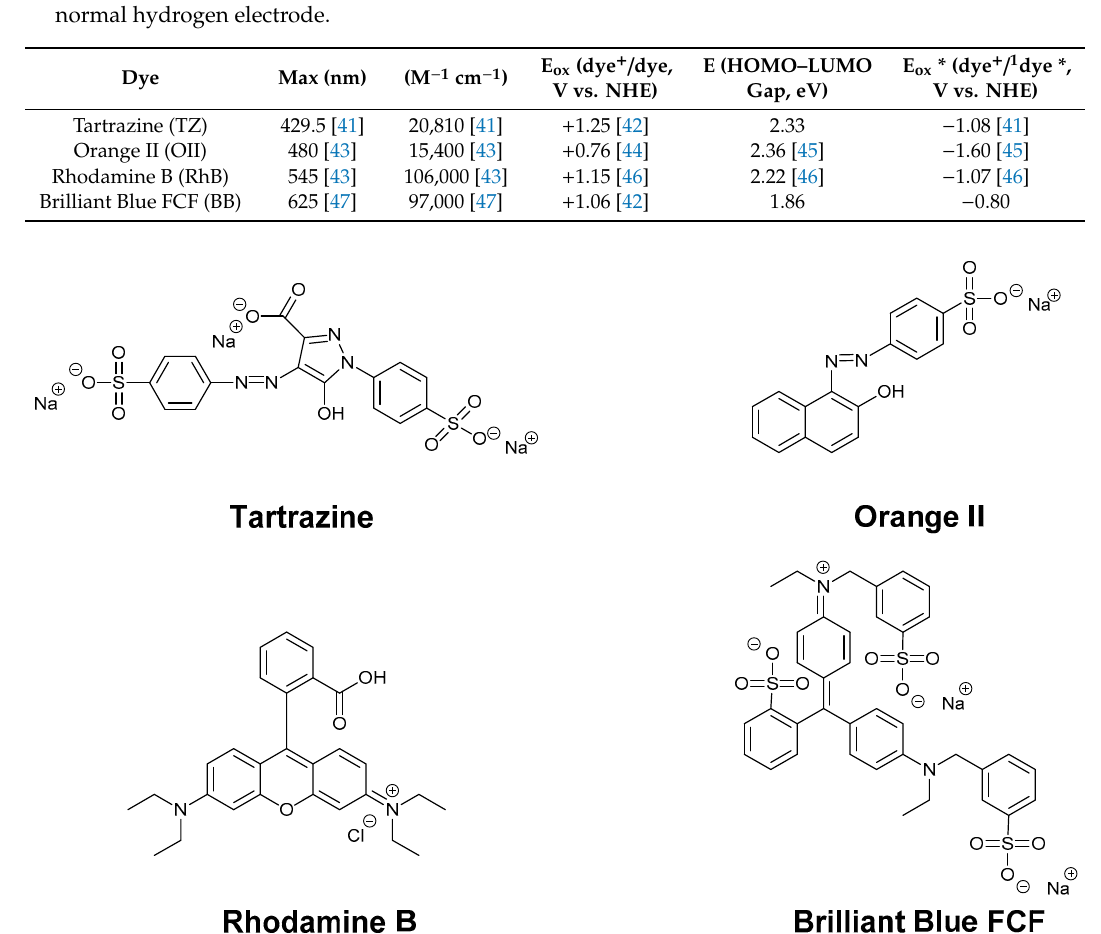
Table 1. Photophysical properties and electrochemical data of the selected synthetic dyes [40]. NHE: normal hydrogen electrode